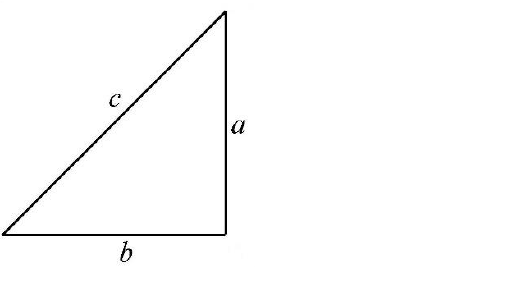
Figure 1. c = hypotenuse, b and a = legs (or base and height).